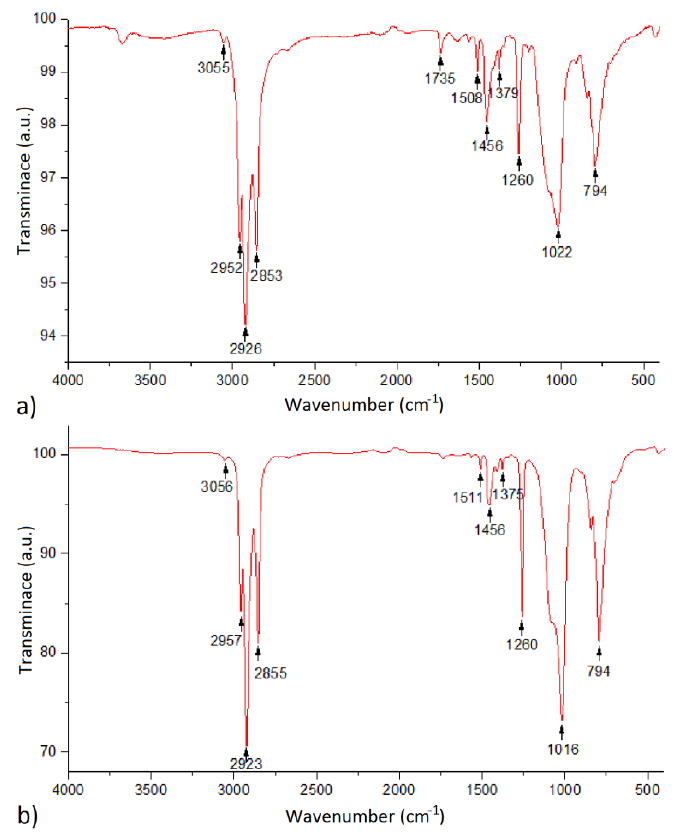
Figure A2. Fourier-transform infrared spectroscopy with the attenuated total reflectance (FTIR-Atr) spectra of ( a ) PEGSil CH; ( b ) DodecSil CH.